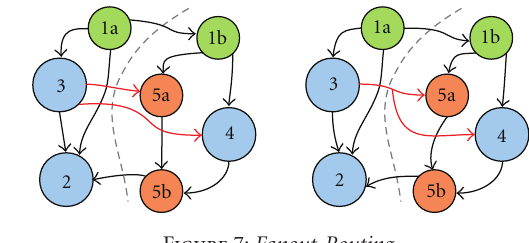
Figure 7: Fanout-Routing.